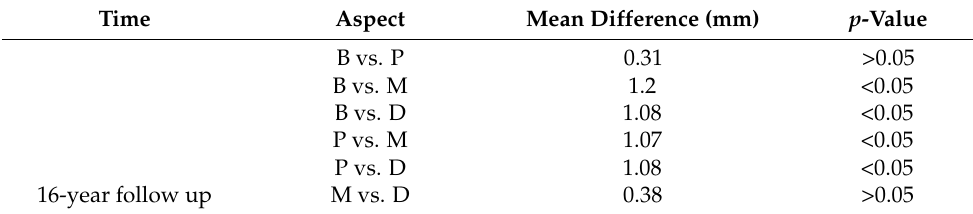
Table 1. Results of the one-way analysis of variance (ANOVA) and Tukey’s post hoc test for the